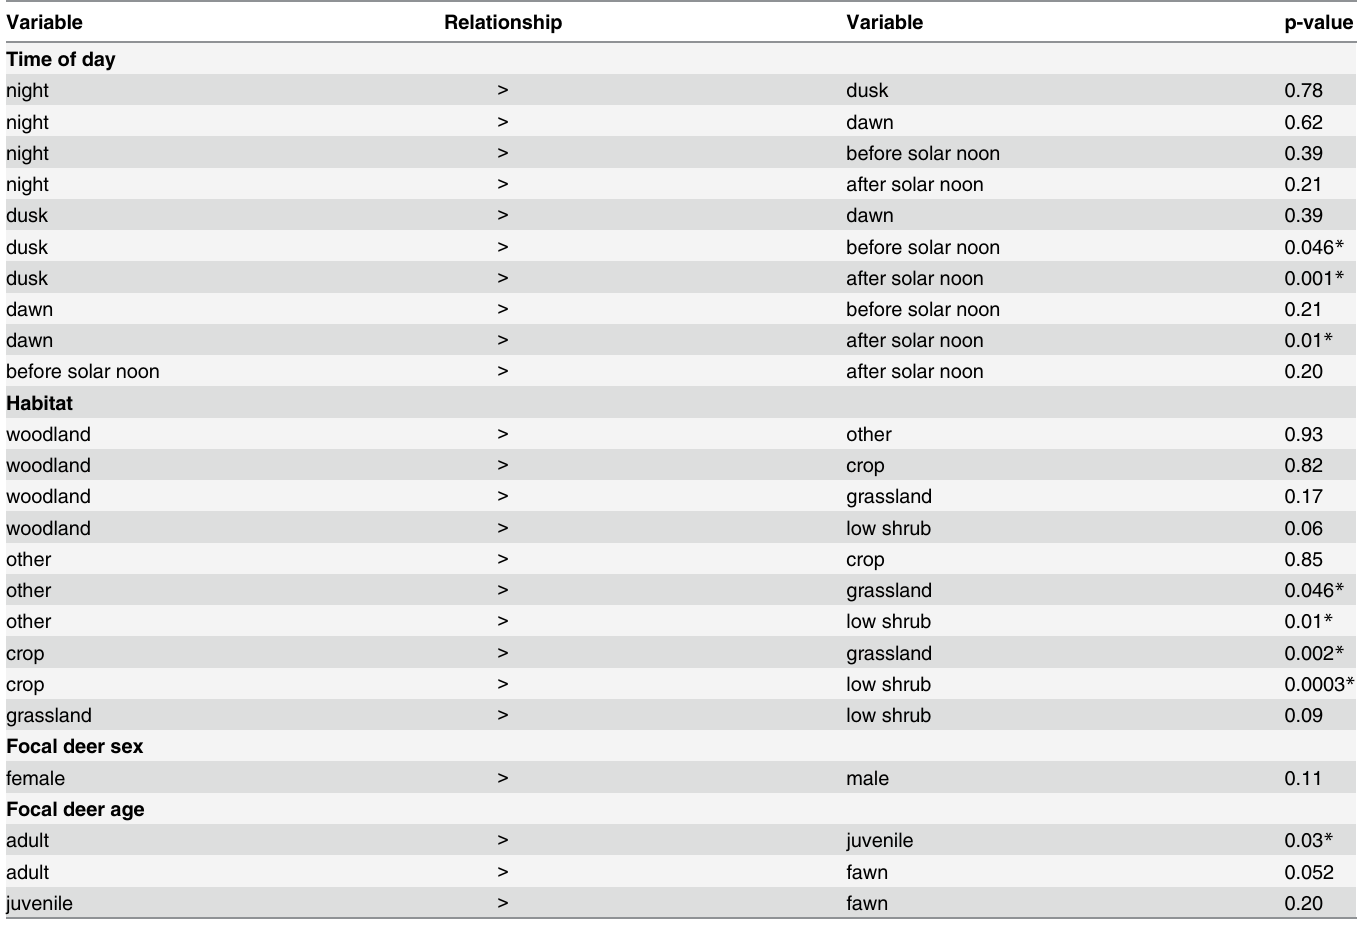
Table 5. Least squares means differences for predicted mean group size according to time of day, habitat, sex of focal deer, and age of focal deer.